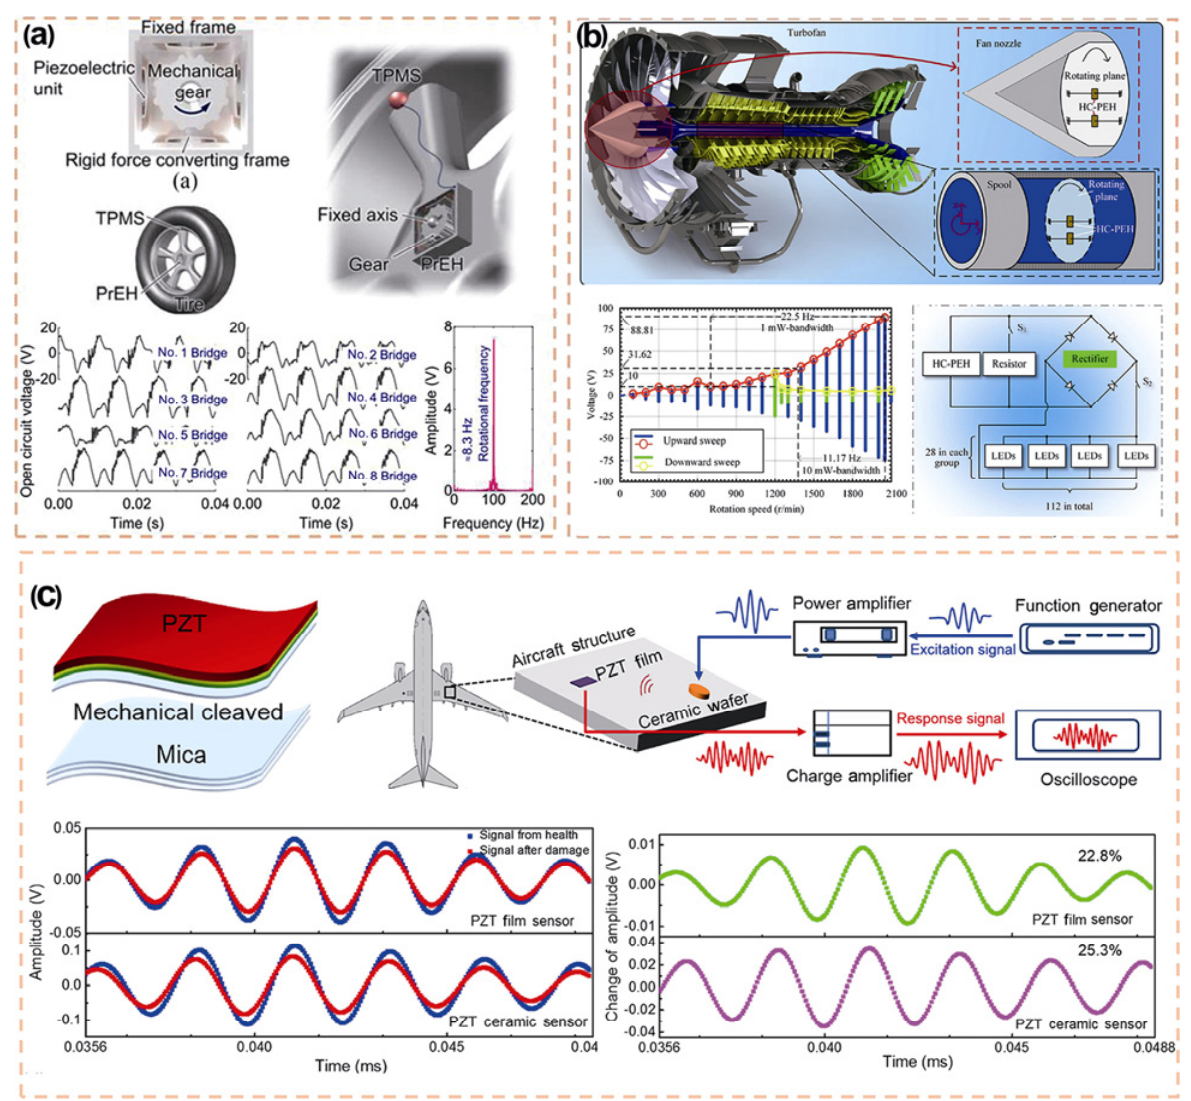
Fig. 11 Industrial application. (a) Illustration schematic of buckled bridge-based piezoelectric rotational kinetic energy harvester and performance of eight channels. (b) Schematic of high-efficiency compressive-mode PEH and demonstrations on energy harvesting. (c) Performance of flexible PZT film sensor for structural health monitoring of aircrafts. Reproduced with permission from Ref. [192] for (a), © IEEE 2020; Ref. [193] for (b), © Elsevier Ltd. 2020; Ref. [194] for (c), © Elsevier Ltd and Techna Group S.r.l.